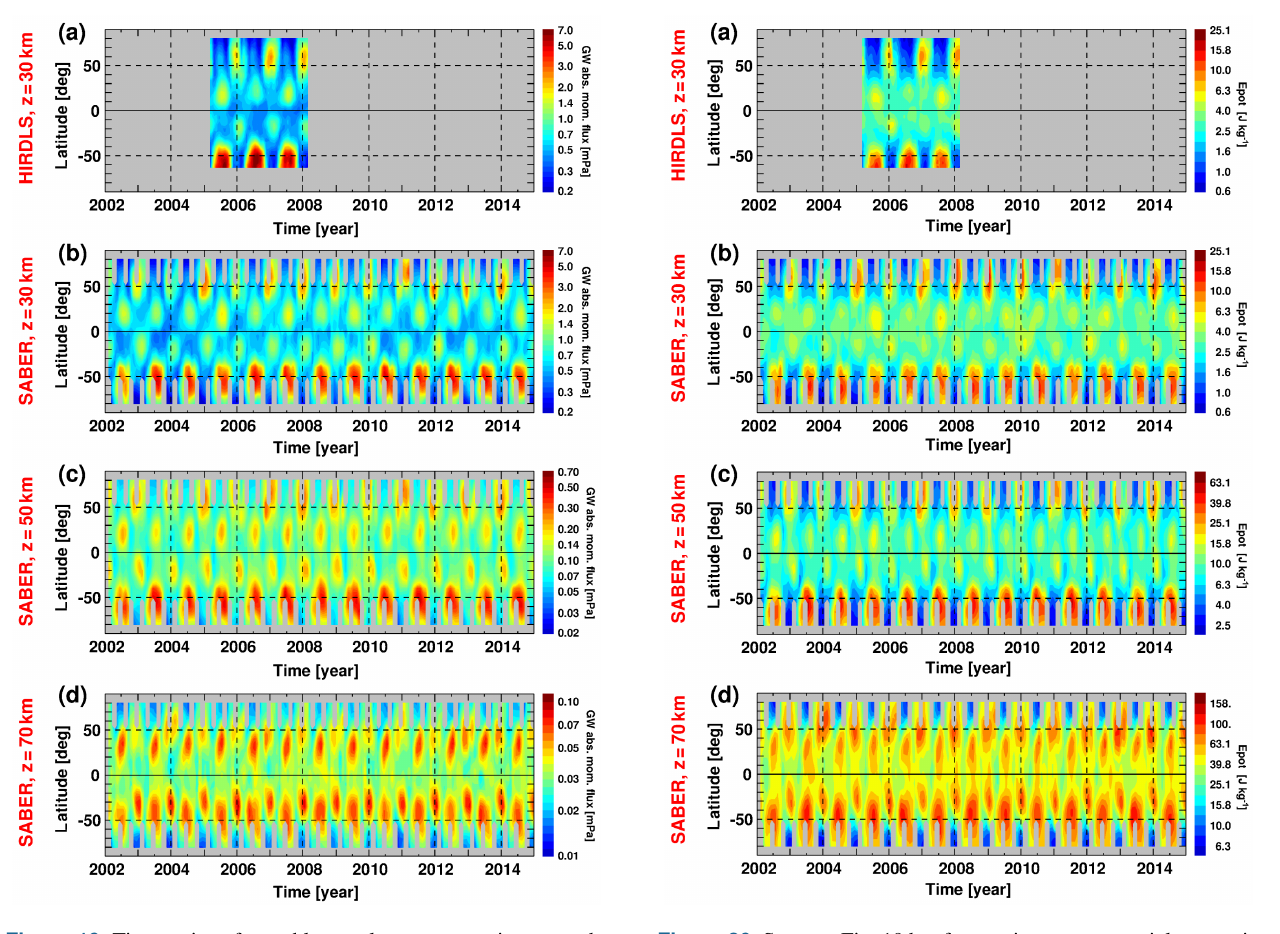
Figure 19. Time series of monthly zonal-average gravity wave ab- solute momentum fluxes at 30km altitude for (a) HIRDLS and (b) SABER, as well as for SABER at (c) 50km and (d) 70km alti- tude. Values are in mPa on logarithmic scales.